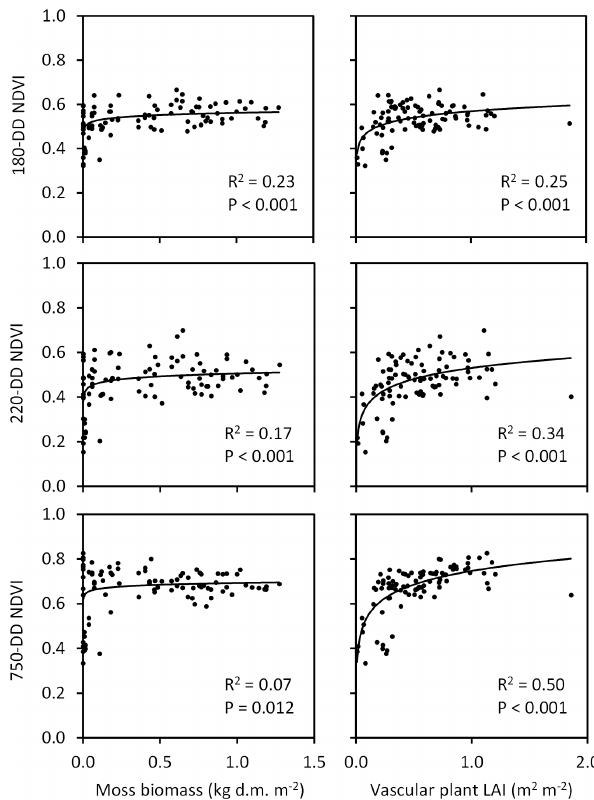
Figure 12. Associations of moss biomass and vascular plant leaf area index (LAI, measured in late July at ca. 360 DD) with NDVI extracted from QB (taken at 180 DD) and WV-2 images (taken at 220 and 750 DD) across the Tiksi tundra field plots ( n = 92, R 2 and P values are from logarithmic regression analysis).